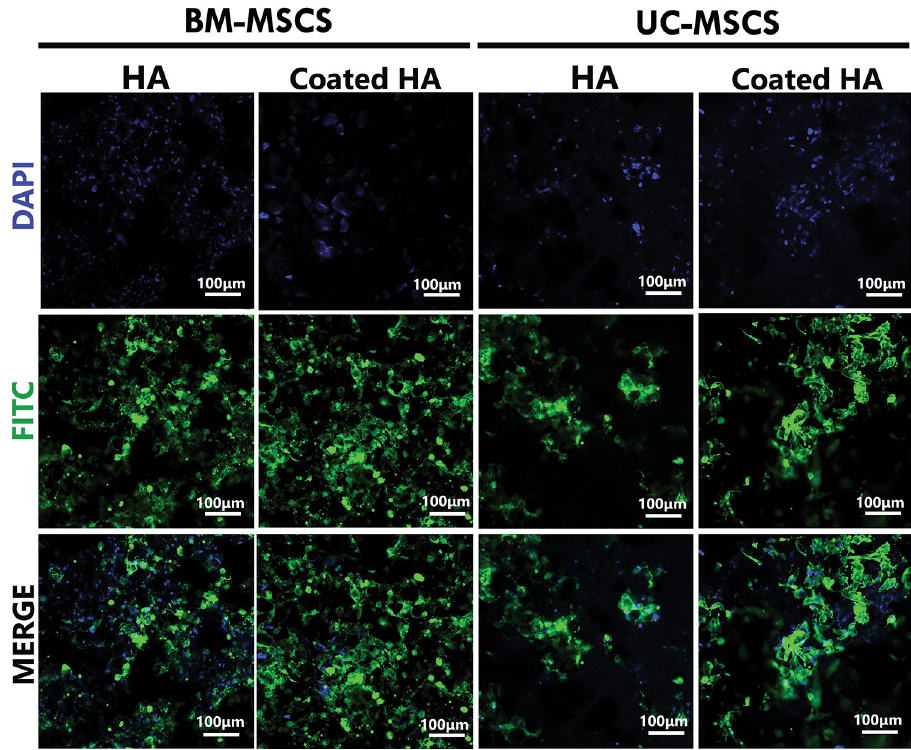
Figure 4. The representative fluorescent micrographs illustrate the actin filament staining (green) in BM-MSCs and UC-MSCs, which attach to the 3D-printed HA (HA) and coated 3D-printed HA (coated HA) on day 28. The nuclei were stained with DAPI (blue).